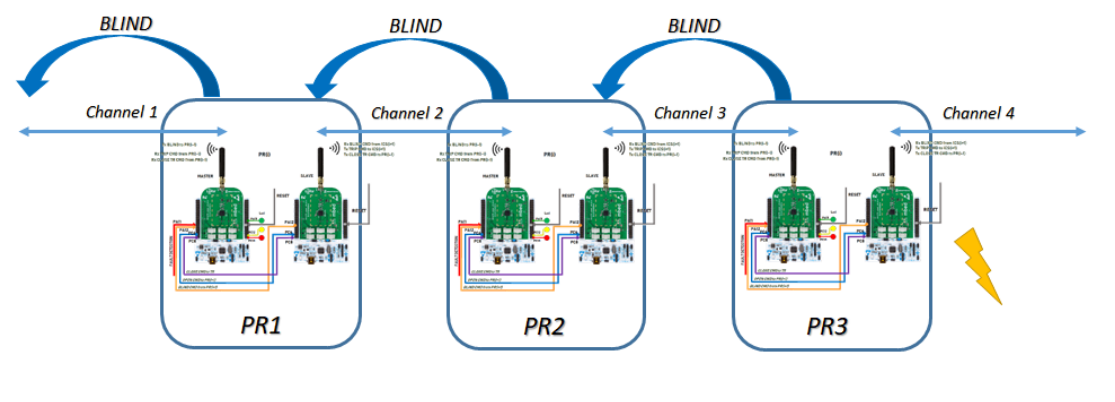
Figure 8. Simultaneous transmission and reception of Blind messages between PRs on different